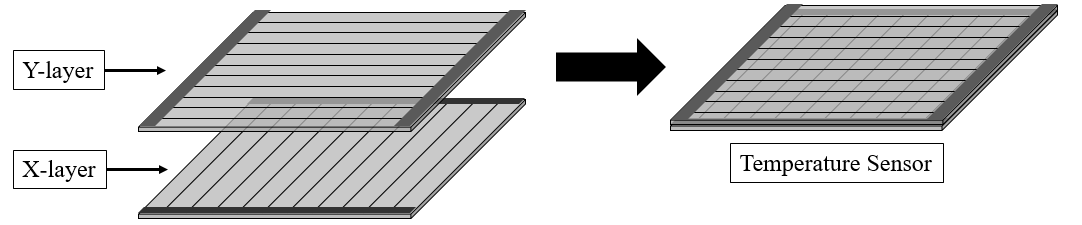
Figure 9. Temperature sensors modeling for heat source detection.